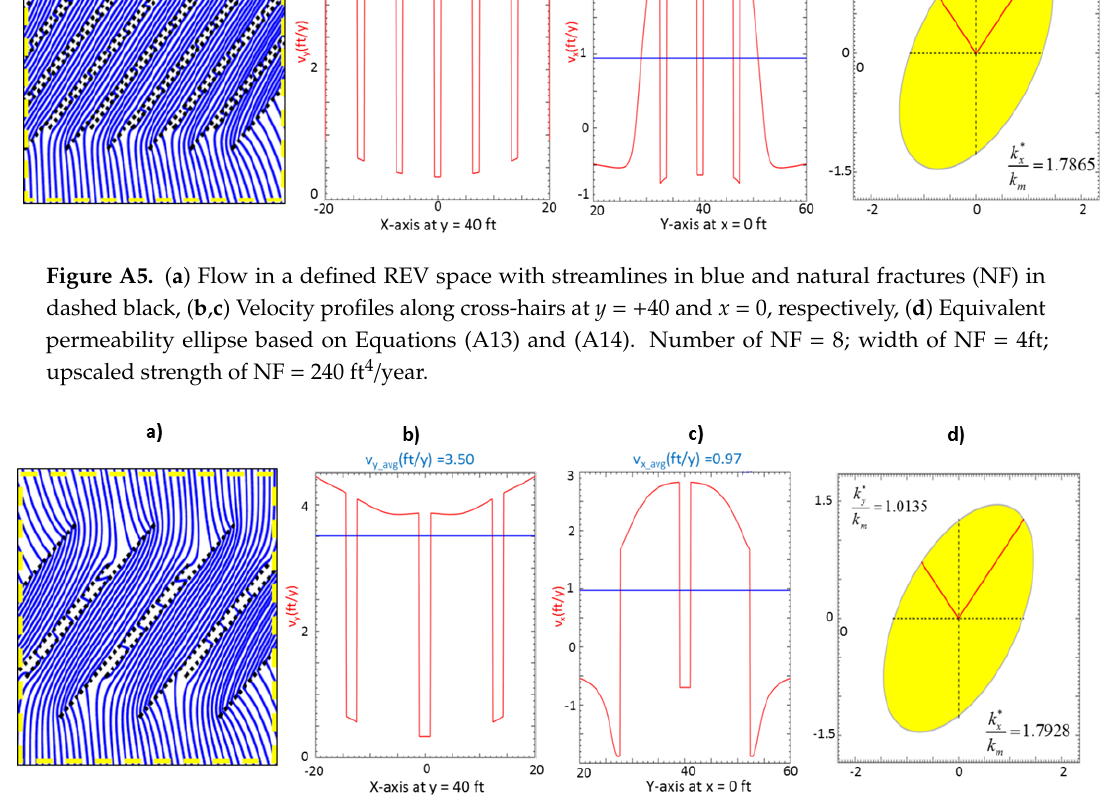
Figure A6. ( a ) Flow in a defined REV space with streamlines in blue and natural fractures (NF) in dashed black, ( b , c ) Velocity profiles along cross-hairs at y = + 40 and x = 0, respectively, ( d ) Equivalent permeability ellipse based on Equations (A13) and (A14). Number of NF = 4; width of NF = 8ft; upscaled strength of NF = 480 ft 4 /year.